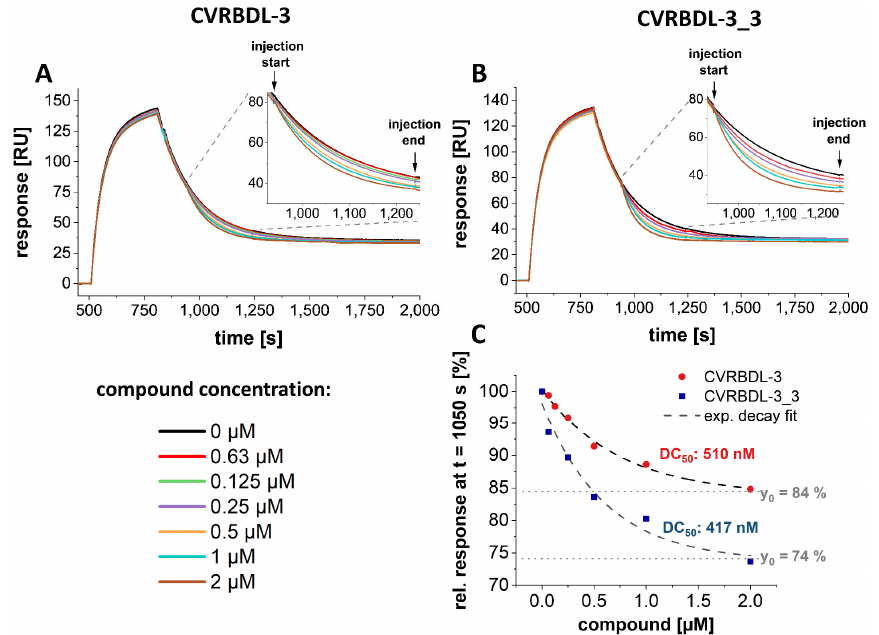
Figure 11. CVRBDL-3 and CVRBDL-3_3 displace hACE2 from the pre-formed complex with Figure 11. CVRBDL ‐ 3 and CVRBDL ‐ 3_3 displace hACE2 from the pre ‐ formed complex with SARS ‐ SARS-CoV-2 S1S2. ( A , B ) hACE2-fc was immobilized on a Protein A/G-derivatized sensor surface in CoV ‐ 2 S1S2. ( A , B ) hACE2 ‐ fc was immobilized on a Protein A/G ‐ derivatized sensor surface in a T200 a T200 SPR device (Cytiva, USA). For all samples, 50 nM SARS-CoV-2 S1S2 was injected for 300 s SPR device (Cytiva, USA). For all samples, 50 nM SARS ‐ CoV ‐ 2 S1S2 was injected for 300 s with 30 with 30 µ L/min. After dissociation start 300 s of CVRBDL-3 ( A ) or CVRBDL-3_3 ( B ) was injected in a concentration range of 62.5 nM to 2 µ M within six steps. All injections including compound were refer- enced with the corresponding concentration of compound only injections on the hACE2 immobilized surface. Injections were performed with 30 µ L/min in 10 mM HEPES pH 7.4, 150 mM NaCl, 3 mM EDTA, 0.005% ( v / v ) Tween-20. ( C ) The response displayed in ( A ) and ( B ) at t = 1050 s of the injection without compound was set to 100%. Relative responses of the compound injections at t = 1050 s were plotted against the corresponding compound concentration. Data fitting was performed using a mono-exponential decay fit (OriginPro, OriginLab, USA). DC 50 [nM] = compound